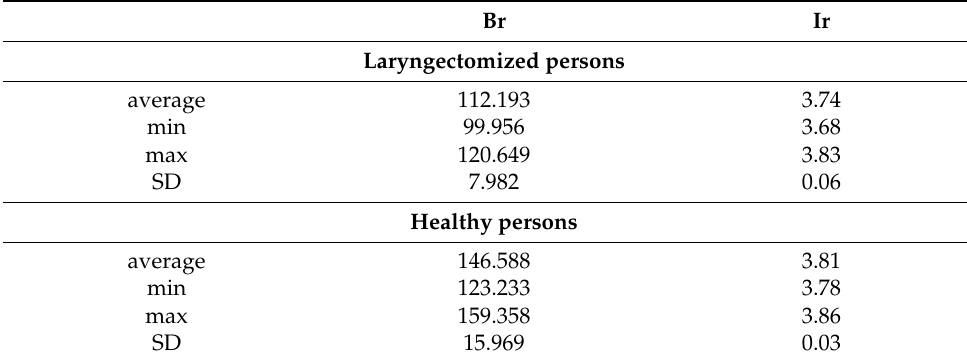
Table 10. The third phonetic segments „ka”—descriptor values—the word “paczka”.